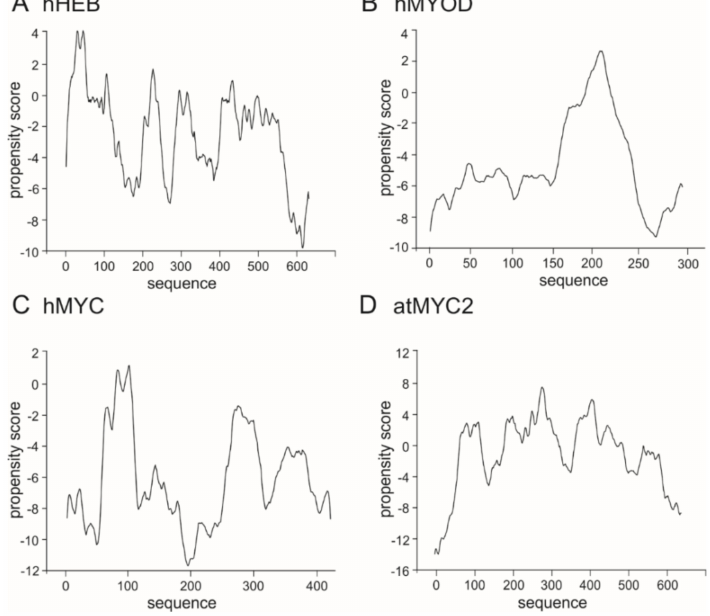
Figure4. PredictionofpropensityofLLPSformation. ( A )classIhumanHEB[Q99081], ( B )classIIhuman